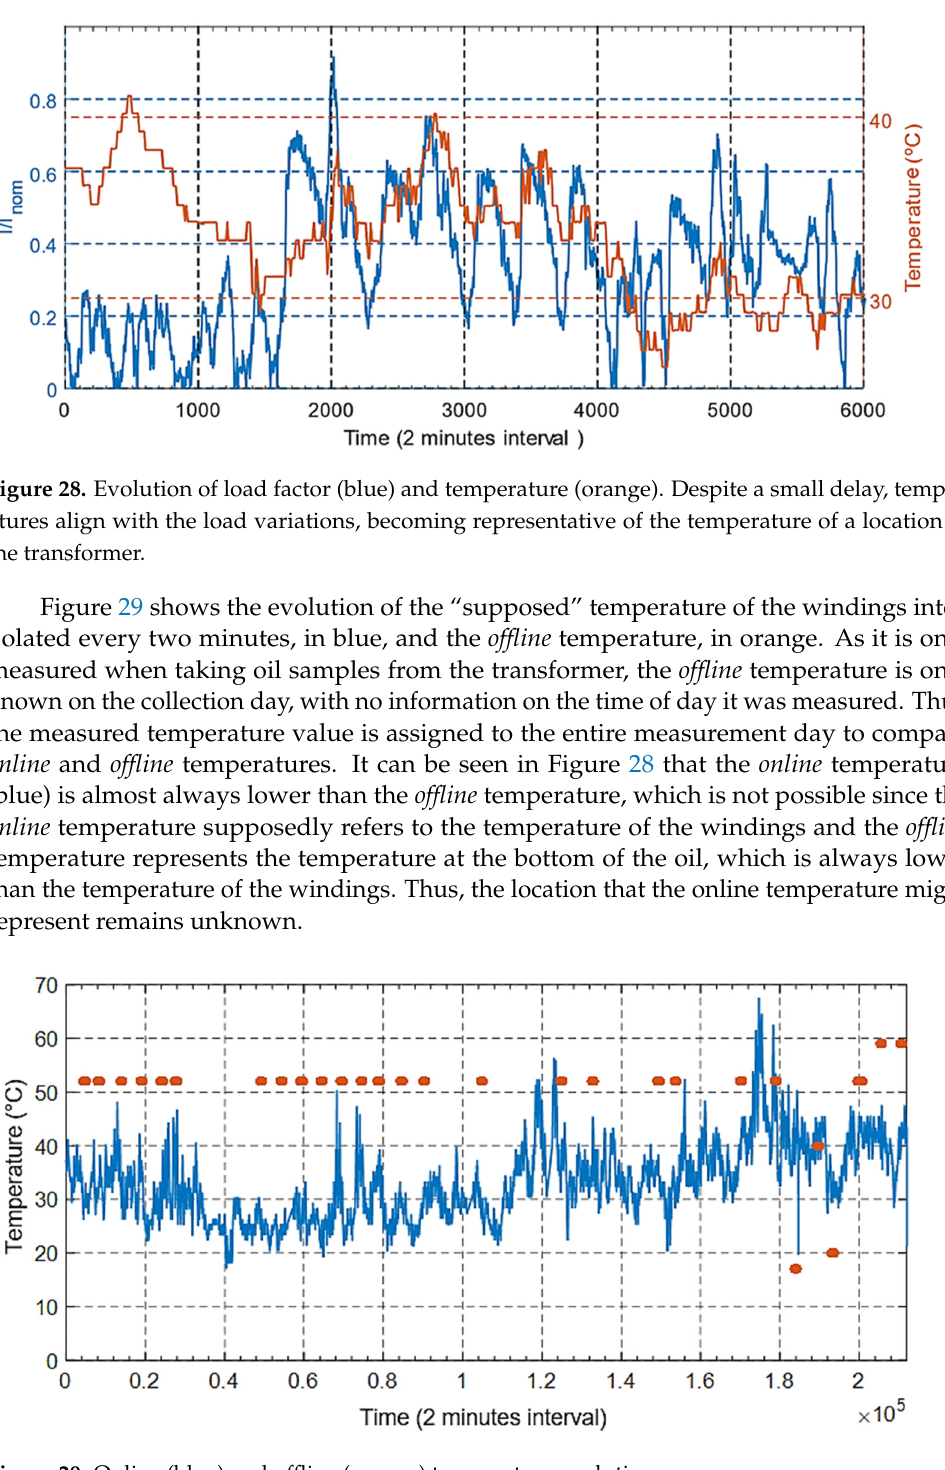
Figure 27. Second week of July: evolution of load factor for different working days (2nd to 6th), presenting a similar pattern as the first week.